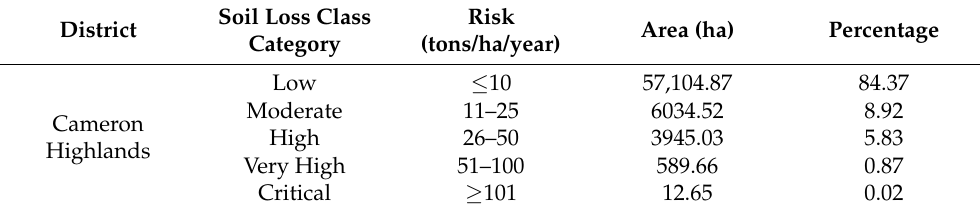
Table 5. Soil loss risk, area and percentage in the Cameron Highlands